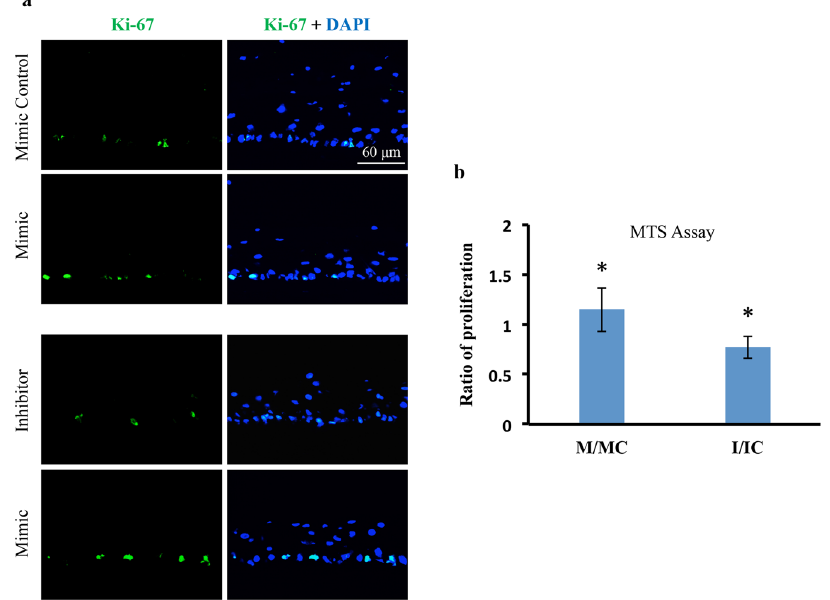
Figure 5. Effect of miR-10b on proliferation in normal human organ-cultured corneas and HCEC. ( a ) miR- 10b treatment in human organ-cultured corneas led to increased expression of Ki-67 in mimic-treated cornea compared to the fellow cornea treated with scrambled control, mimic control, or miR-10b inhibitor. ( b ) MTS proliferation assay showed significant increase or decrease in proliferation rates in HCEC transfected with miR-10b (M), or miR-10b inhibitor (I), respectively, in comparison to their respective transfected scrambled controls, mimic control (MC) and inhibitor control (IC). * P < 0.05, compared with scrambled control values by paired two-tailed t